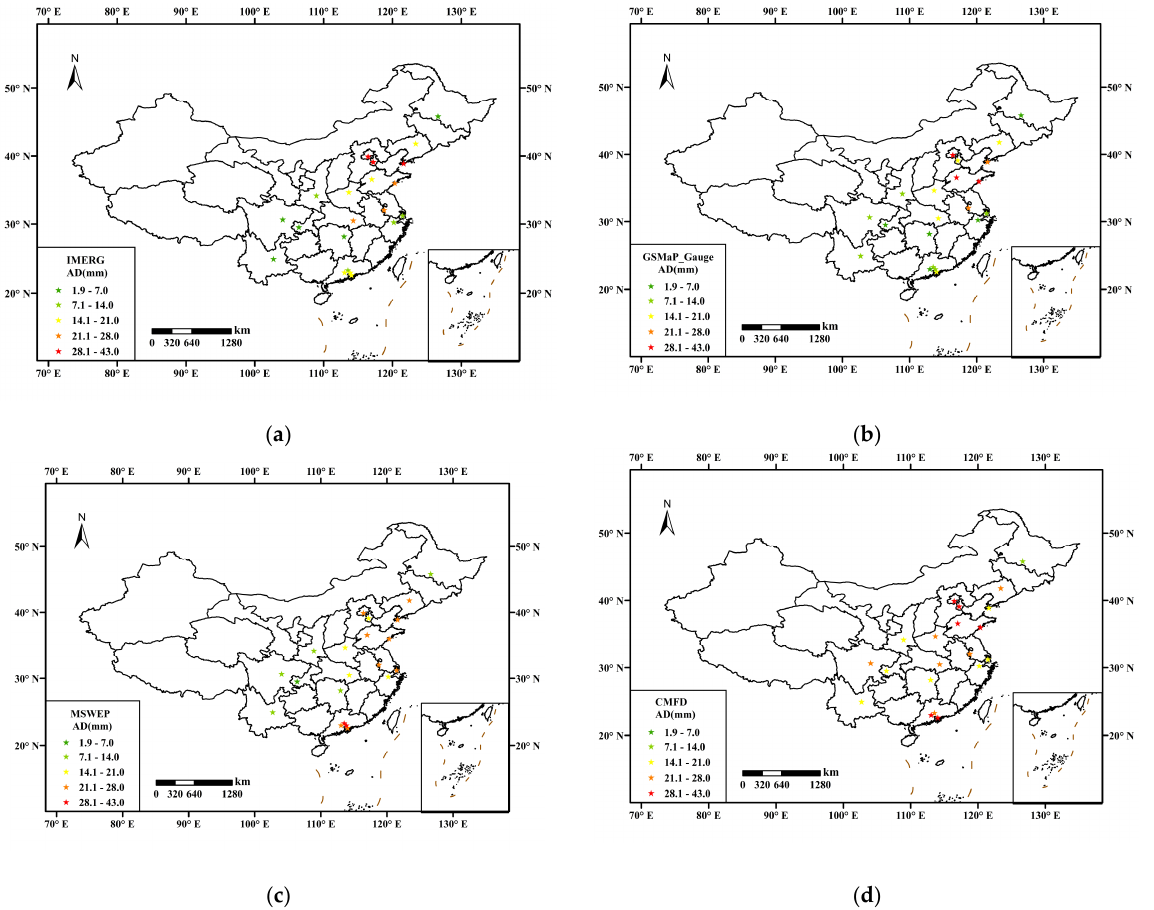
Figure 5. The absolute deviation between R99 values of SPPs data and rain gauges in 21 major cit-